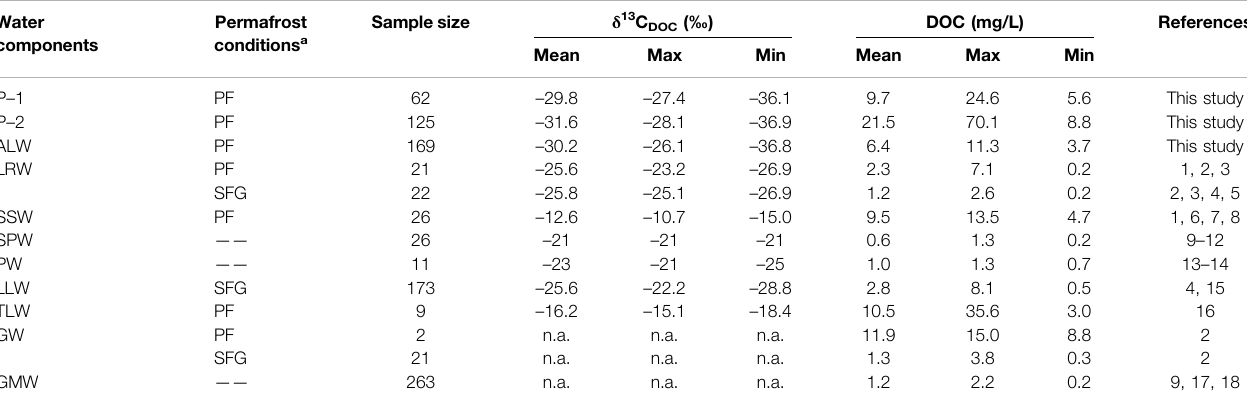
TABLE 1 | DOC and δ 13 C DOC in different water components on QTP.